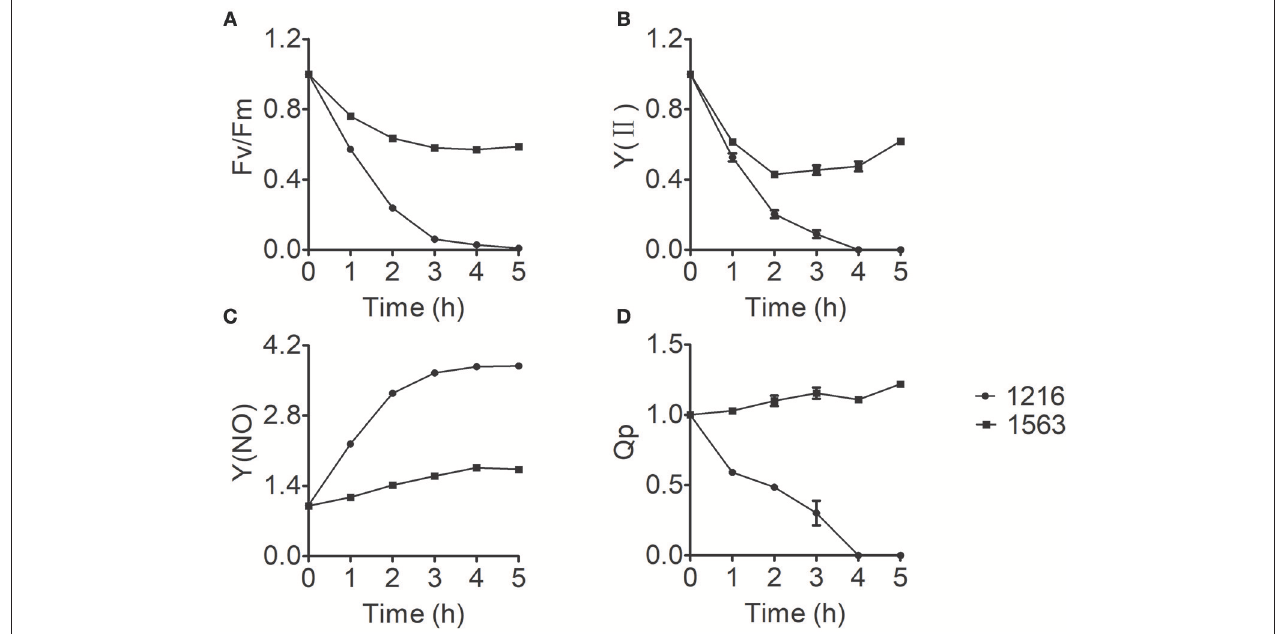
FIGURE 8 | Immunoblot analysis was performed using an antibody specific to D1 and CP43 (lower panels). Equal loading was confirmed by Coomassie brilliant blue staining (upper panels). (A,B) Represent Chlorella strain FACHB-1216 and FACHB-1563, respectively.